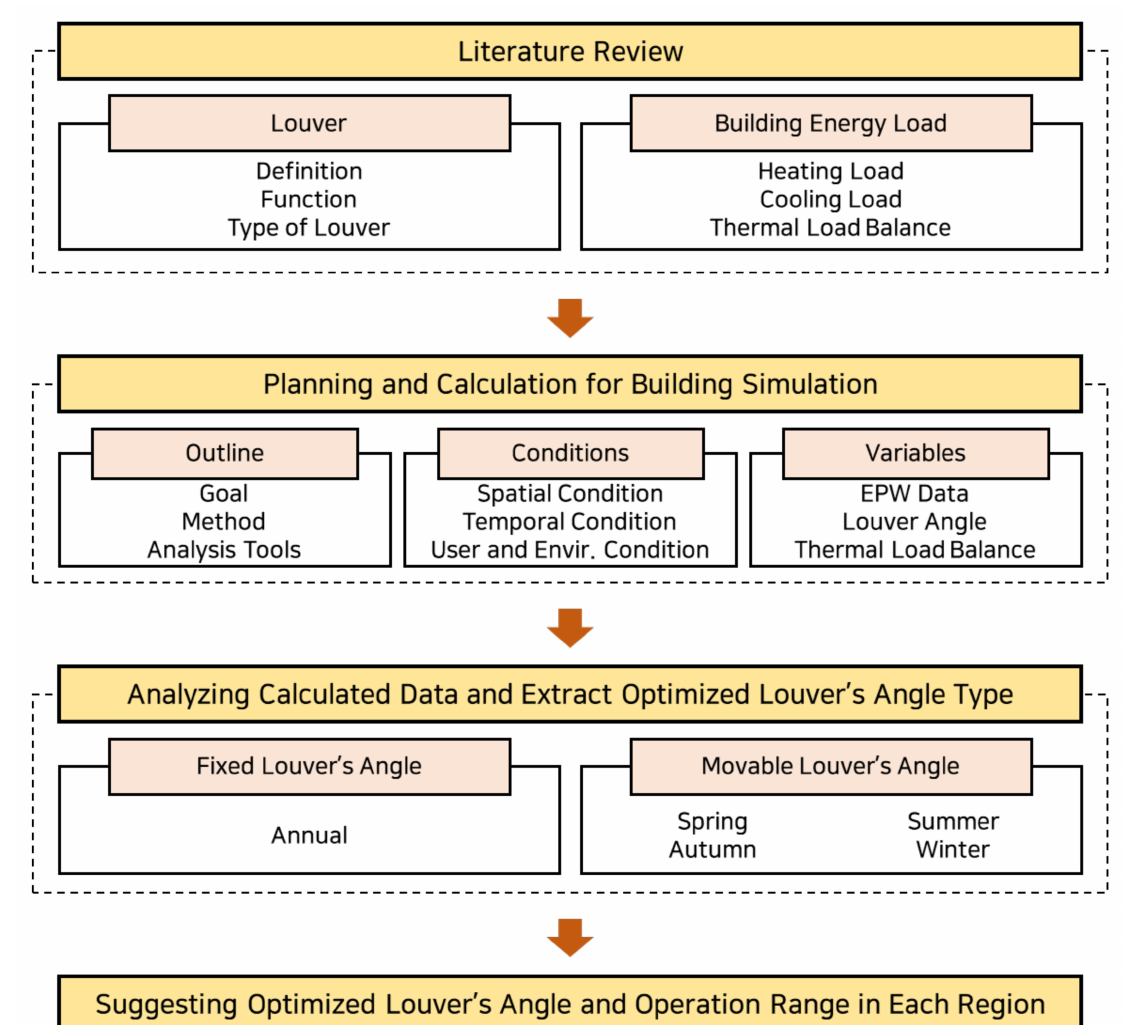
Figure 1. Research